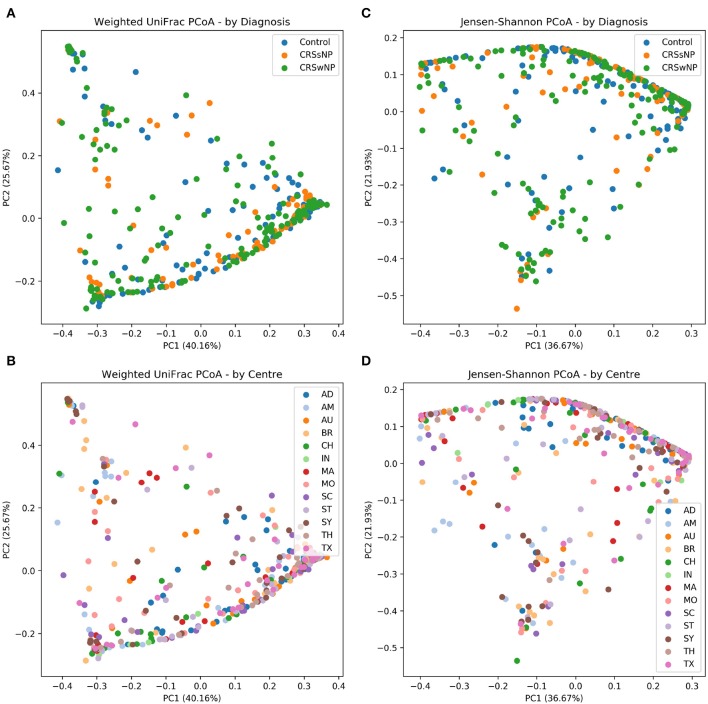
Beta diversity ordination plots. (A) Weighted UniFrac PCoA - by Diagnosis. (B) Weighted UniFrac PCoA - by Centre. (C) Jensen-Shannon PCoA - by Diagnosis; (D) Jensen-Shannon PCoA - by Centre.